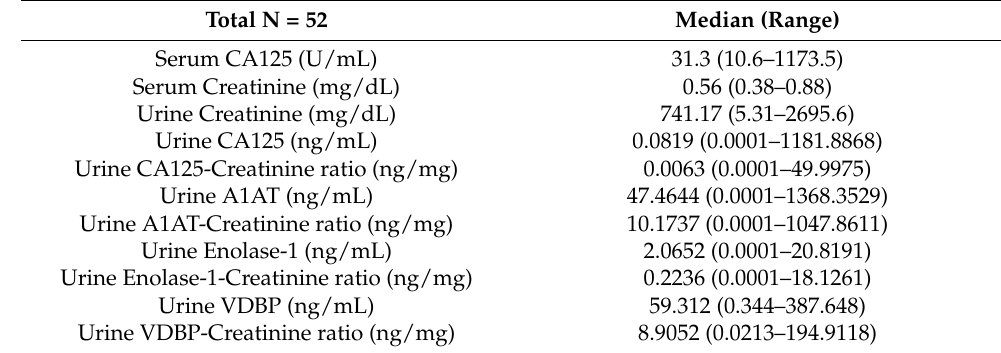
Table 2. The median values of experimented biomarkers.